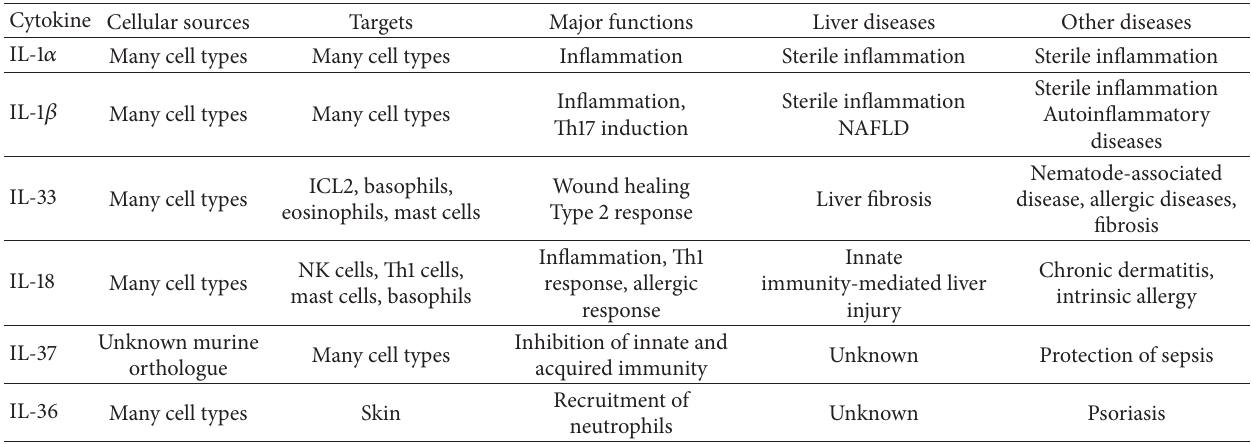
Table 1: Pathophysiological roles of IL-1 family members. The cellular source, target cells, and major functions of IL-1 family cytokines are shown. Representative diseases involving each cytokine are also shown. The precise disease relevancy is described in the text. Cytokine Cellular